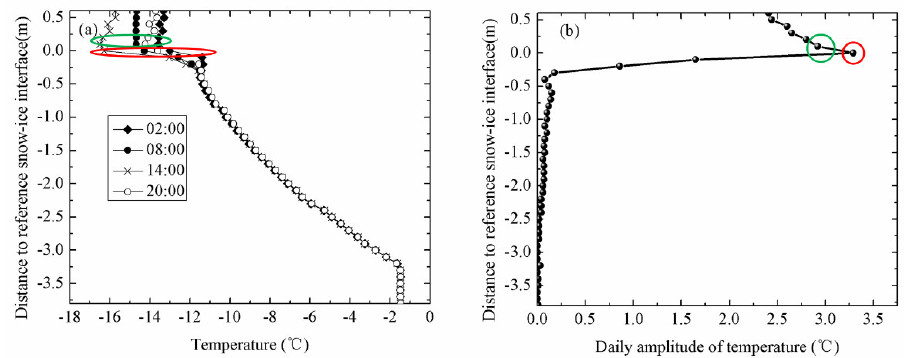
Figure 4. ( a ) Temperature profiles of IMB-2007E on 2 May and ( b ) the daily amplitudes of temperature. The green circle is the air-snow interface and the red circle is the snow-ice interface.